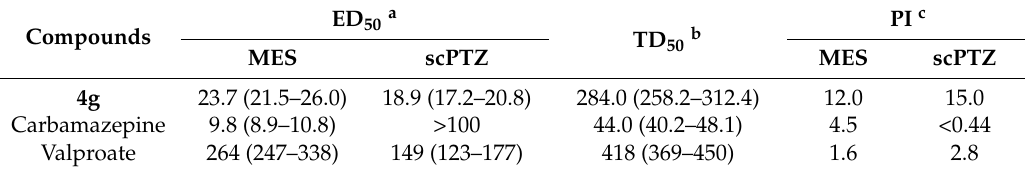
Table 2. Quantitative anticonvulsant date of 4g (anti-MES and anti-PTZ) in mice administered